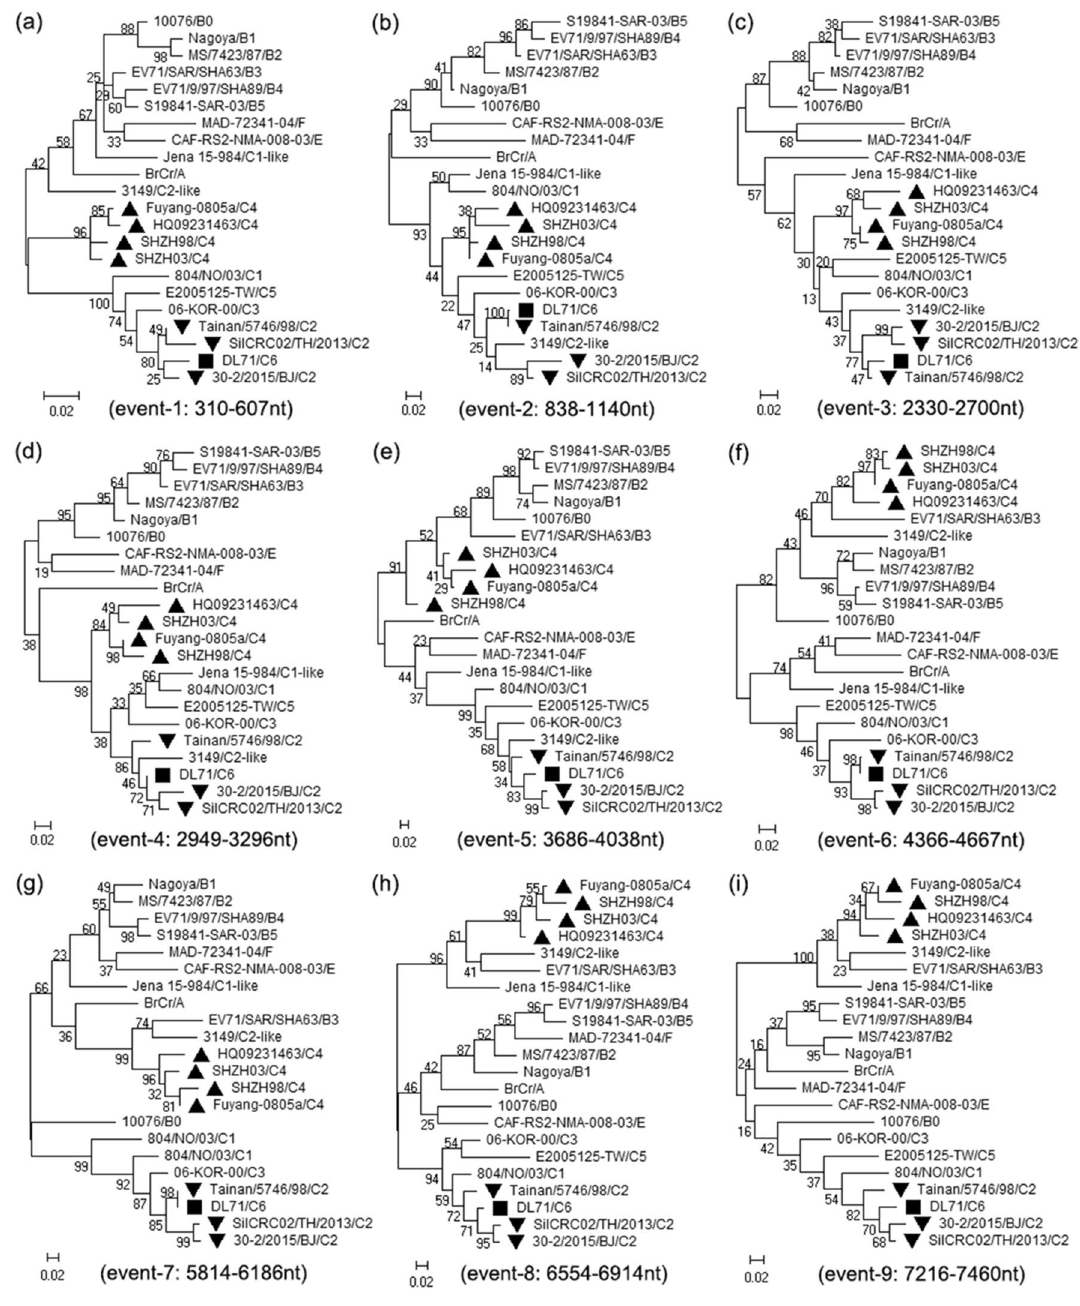
Figure 5. Phylogenetic trees based on the recombination regions of DL71. The regions ( a ) 310–607 bp, ( b ) 838–1140 bp, ( c ) 2330–2700 bp, ( d ) 2949–3296 bp, ( e ) 3686–4038 bp, ( f ) 4366–4667 bp, ( g ) 5814–6186 bp, ( h ) 6554–6914 bp, and ( i ) 7216–7460 bp of DL71 and other reference strains were used to construct the phylogenetic trees by the maximum likelihood method with 1000 bootstrap replicates. The recombinant strain DL71, the major parental strain and the minor parental strain are indicated with “black filled square”, “black filled upward triangle” and “black filled downward triangle”,